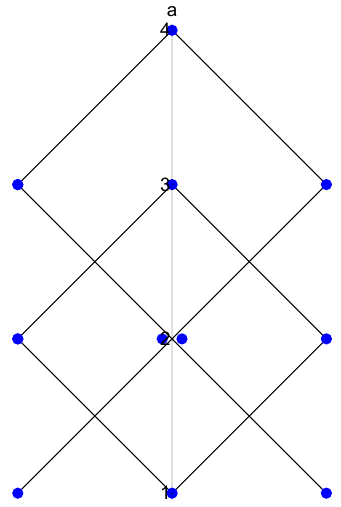
Figure 5 . Homological diagram for 7 2